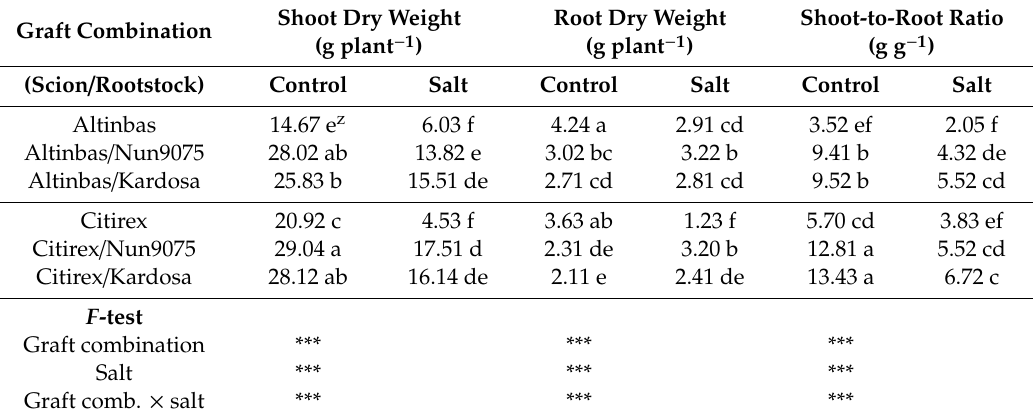
Table 1. Shoot and root dry weight and shoot-to-root ratio of melon graft combinations under